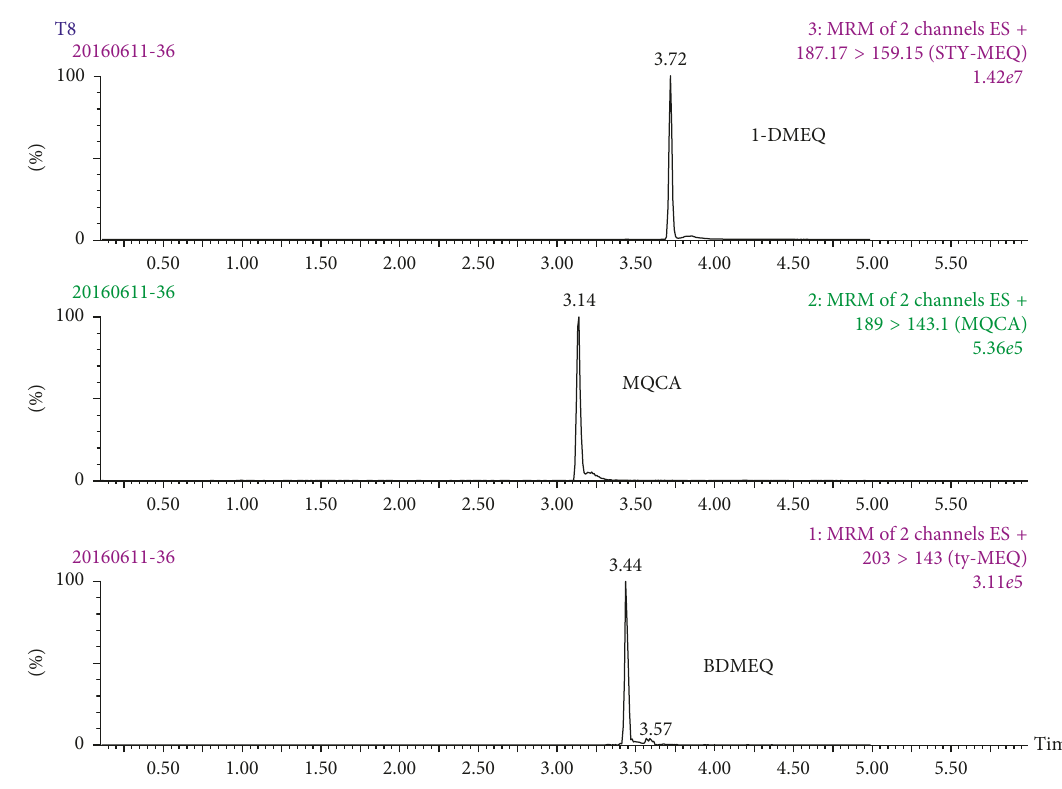
Figure 2: MRM chromatograms of blank holothurian samples fortified at 10 µ